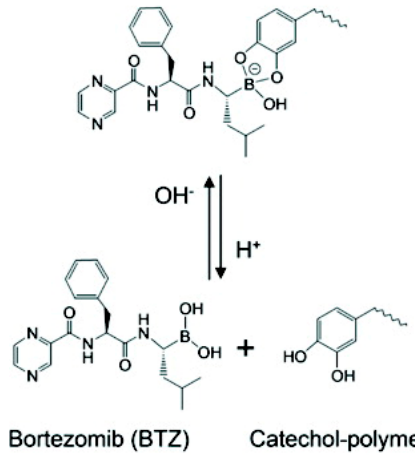
Figure 6 . Catechol-containing polymers conjugated the boronic acid containing anticancer